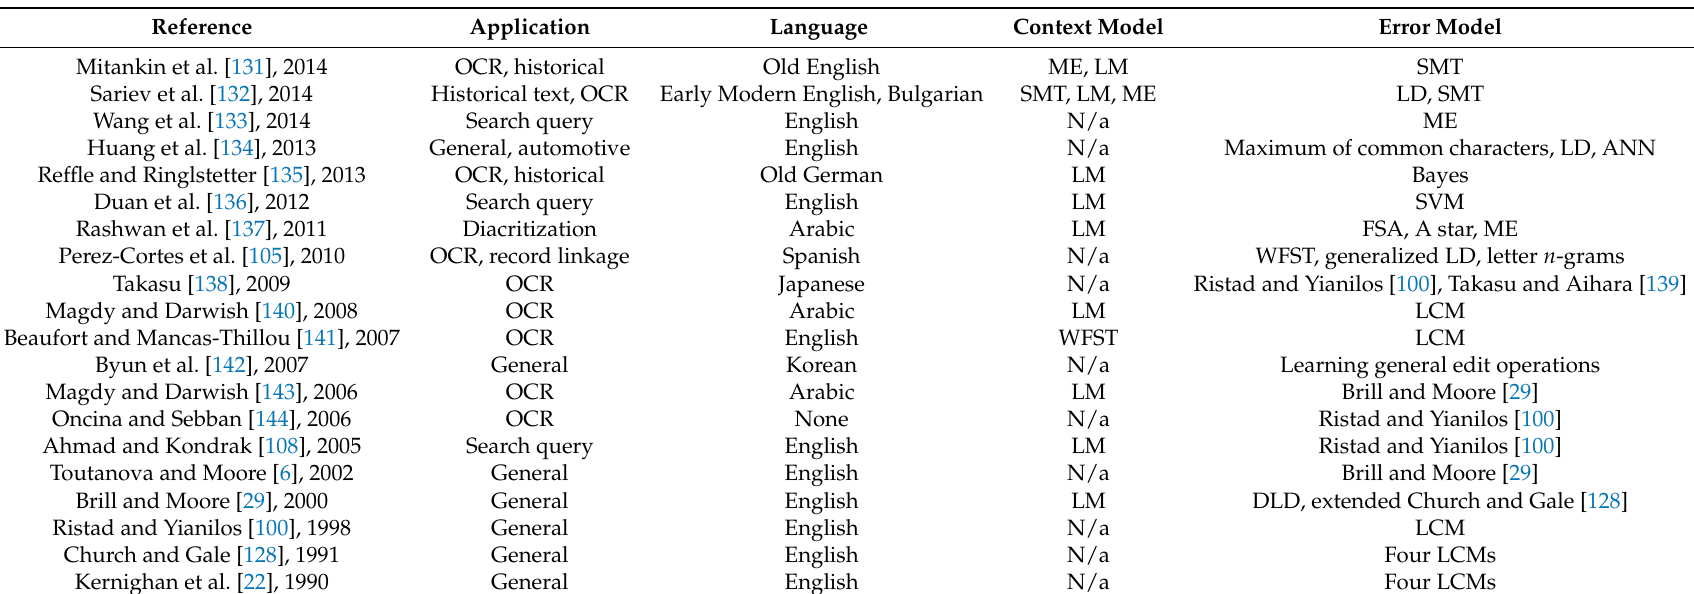
Table 6. spelling correction systems with learning of context model and error model—part